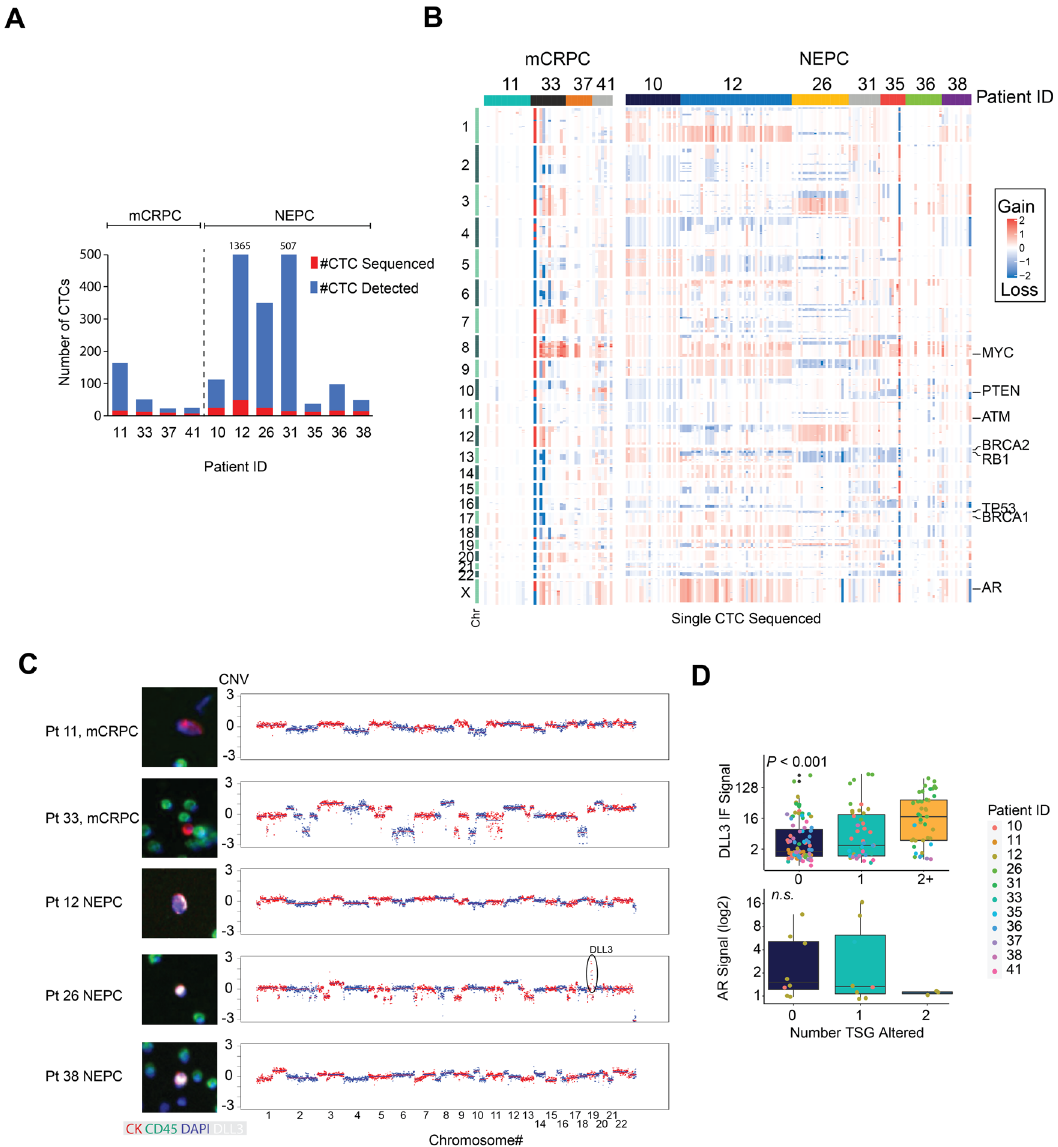
Fig. 3 Genomics of single-cell CTCs. A The number of CTCs detected vs single-cell sequenced. B Copy number pro fi les across chromosomes for each CTC sequenced. C Intensity of DLL3 or AR protein expression assess my immuno fl uorescence compared tumor suppressor loss (PTEN, RB1, and P53) in single CTCs. D Representative copy-number pro fi les and corresponding CTC image from 5/11